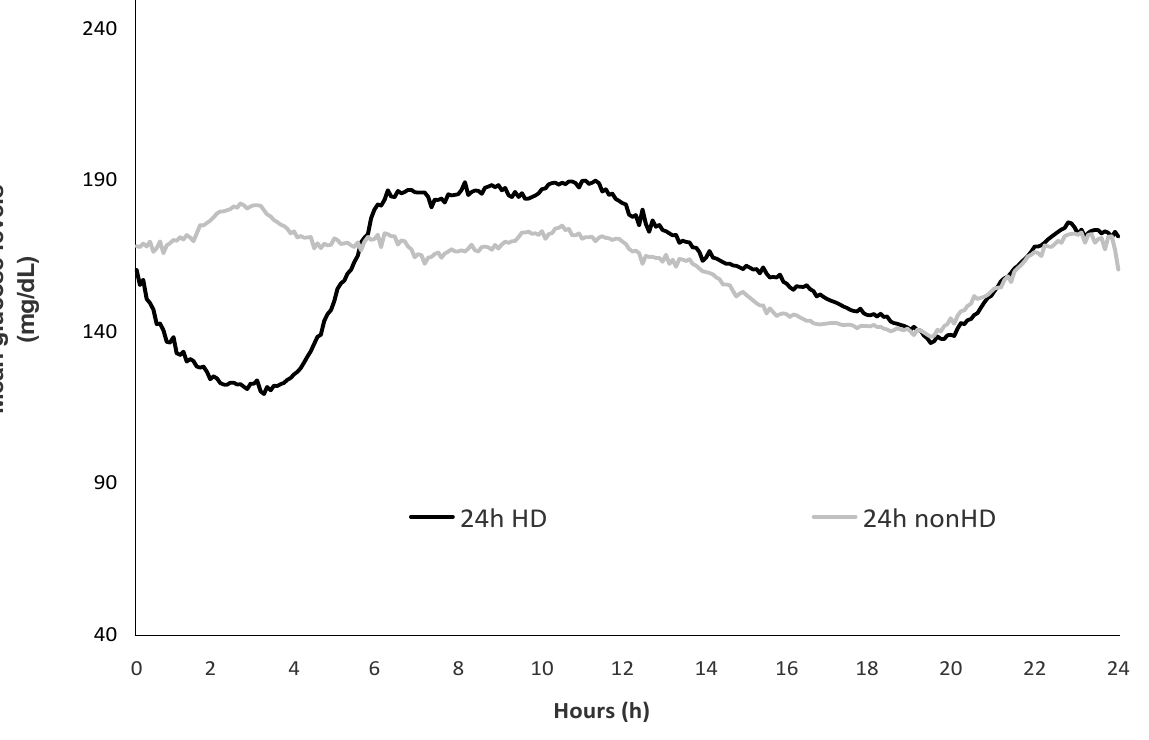
Figure 2. Glucose variation over the 24 h periods of the dialysis-on and dialysis-off days. Abbreviations: 24 h HD = dialysis-on day; 24 h nonHD = dialysis-off Table 3. Comparison of CGM-derived parameters between dialysis-on and dialysis-off days. Parameter